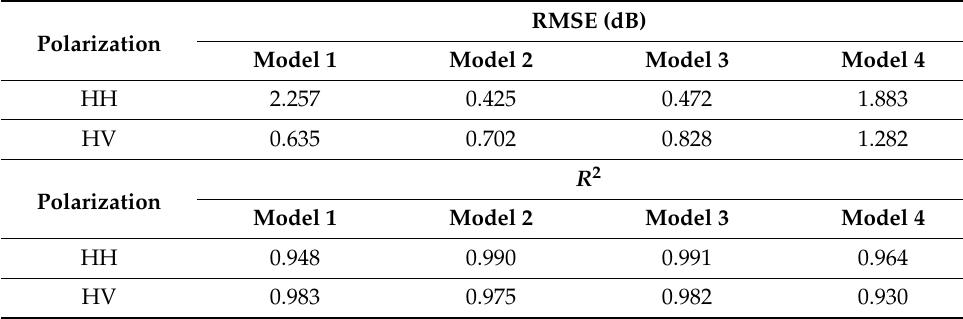
Table 4. RSME values for the WCM-simulated and observed backscatter using PALSAR-2 with different vegetation